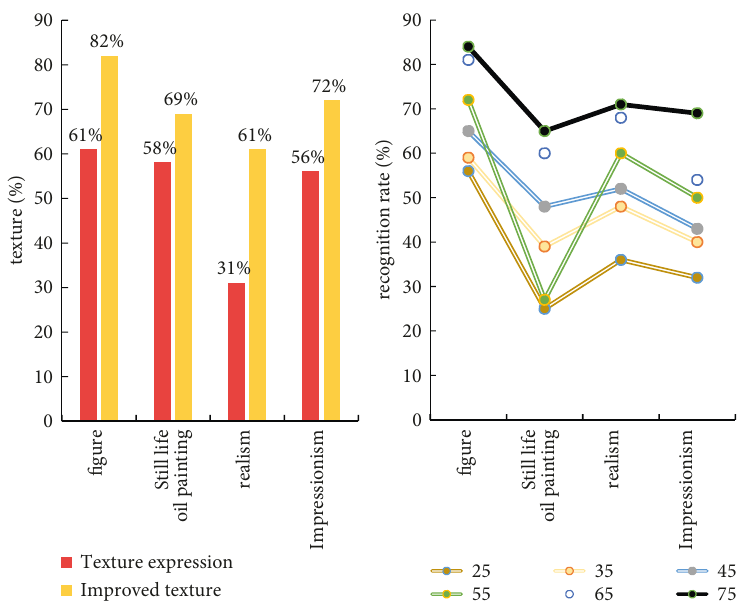
Figure 7: Comparison of the texture of the oil painting before and after the improvement.